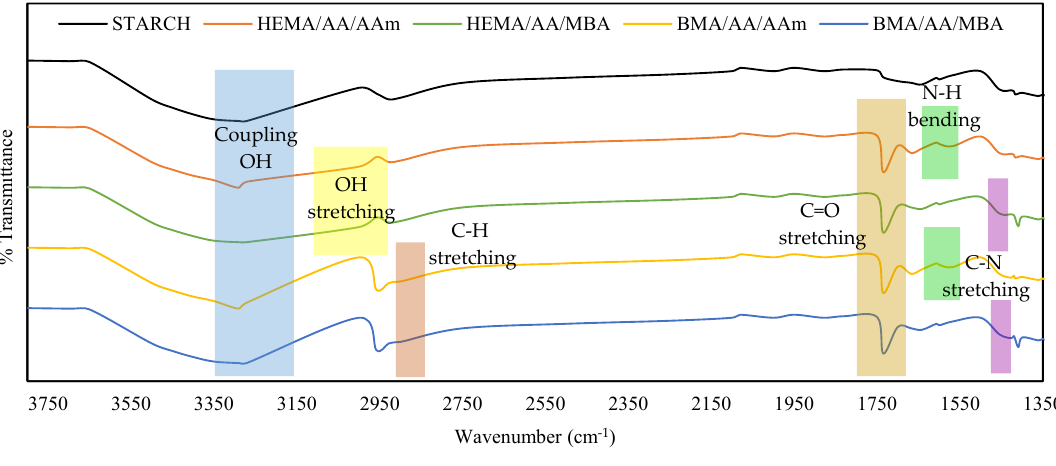
Figure 3. FTIR spectra of starch, HEMA/AA/AAm, HEMA/AA/MBA, BMA/AA/AAm, and BMA/AA/MBA hydrogels.